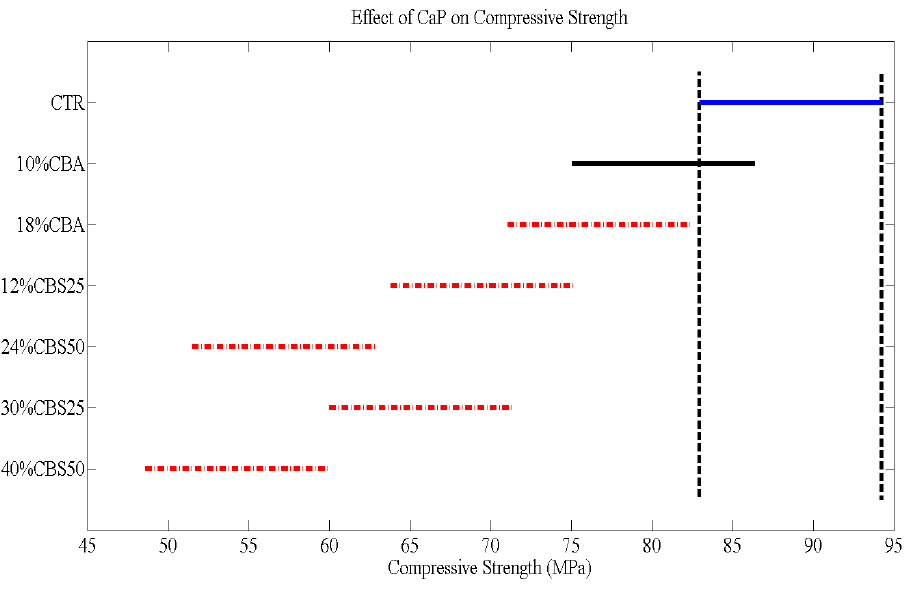
Figure 7. Analysis of Variance (ANOVA) values of the mechanical strength data presented in Figure 6. Vertical dotted lines indicate the level of statistical significance. Samples which fall outside of these margins are statistically different across their